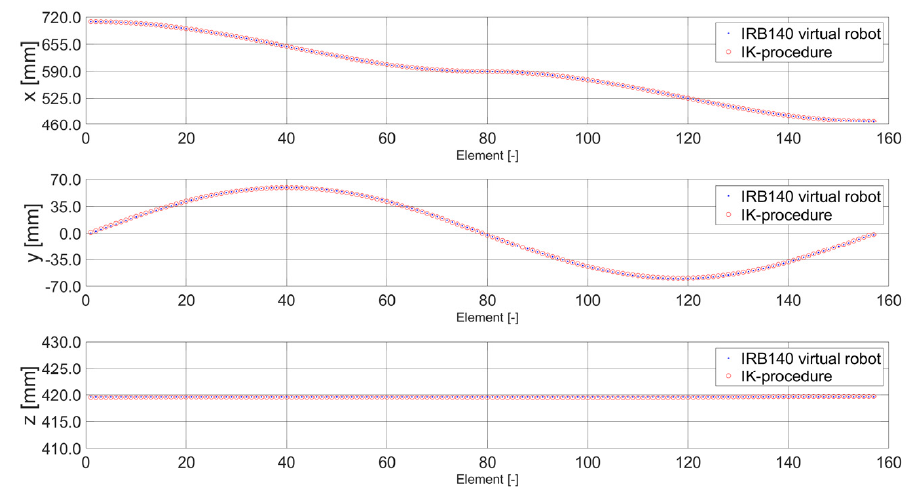
Figure 10. S-shape: X-, Y-, Z- axes Virtual IRB140 vs. IK procedure.